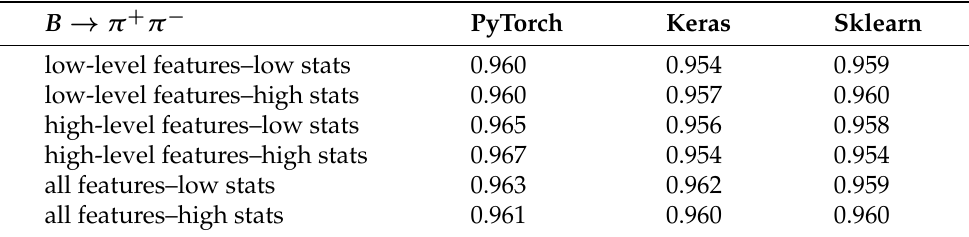
Table 6. B π + π − channel: AUC scores for the different classifiers with all the libraries. → B → π + π −